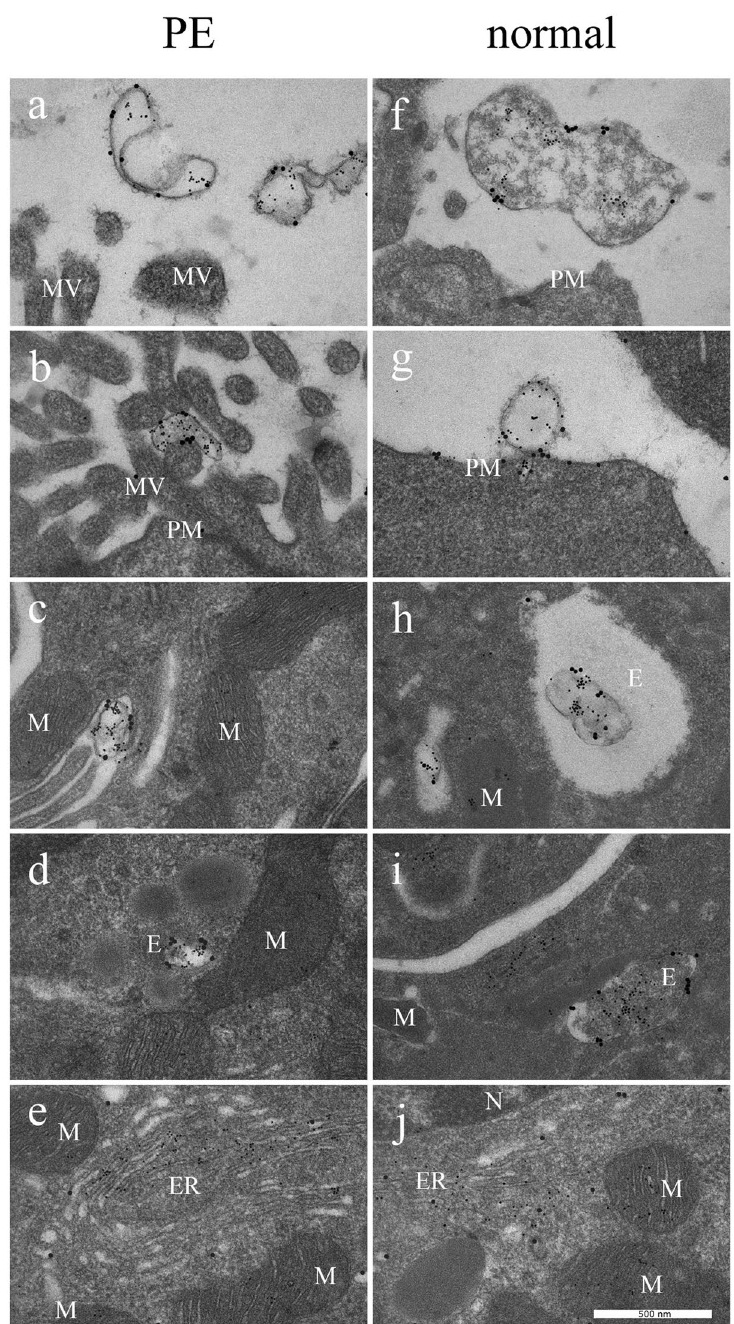
Figure 6. STBEV uptake and miRNA transfer visualised by transmission electron microscopy. By using TEM, PE STBEVs ( a–e ) and normal STBEVs ( f–j ) were visualized in HCAECs. In panel (a), PE STBEVs approach the HCAEC. In ( b ) and ( c ), PE STBEV appears to be binding to the ruffled plasma membrane. The STBEV is seen inside the cells in what appears to be an endosome ( d ), in close proximity to the mitochondria, endoplasmic reticulum and cell nucleus. The mir-517c from PE STBEVs appears to be in larger number in the ER ( e ) compared to the mitochondria. PLAP appears to stay in the endosomes and is possibly recycled to the cell membrane. The normal STBEVs, which also carry mir-517c are found outside the cells ( f–g ) and can be found in endosomes ( h,j ). In contrast to PE STBEVs, mir-517c from normal STBEVs are localized in a higher degree to mitochondria and in lower quantity to the ER ( j ). The STBEV and miRNA intracellular distribution are also described in Table 1. Abbreviations; E endosome, ER endoplasmic reticulum, MV microvilli, M mitochondria, N nucleus, PM plasma membrane. PLAP labelled with 20 nm and mir-517c labelled with 5 nm colloidal